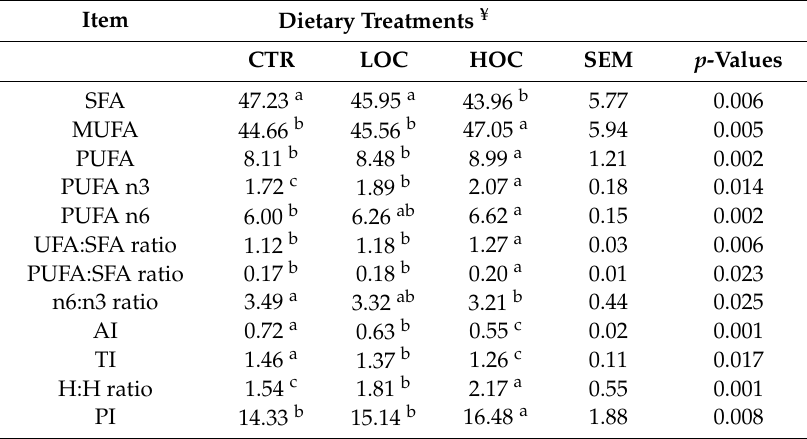
Table 7. E ff ect of dietary olive cake supplementation on fatty acid classes (g / 100 g) § , ratios and nutritional indices of total lipids in the Longissimus lumborum muscle of Limousin young